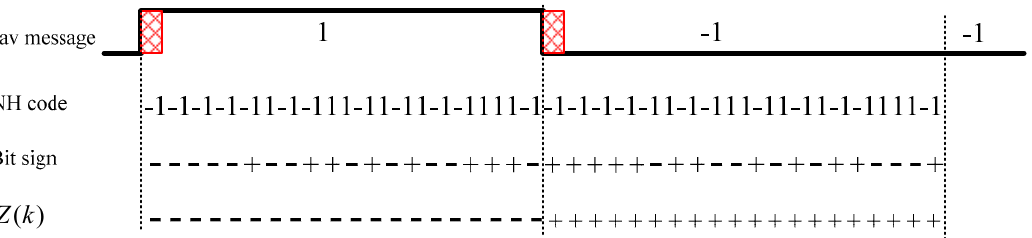
Figure 5. Data signs differential coherent algorithm with long delay time.